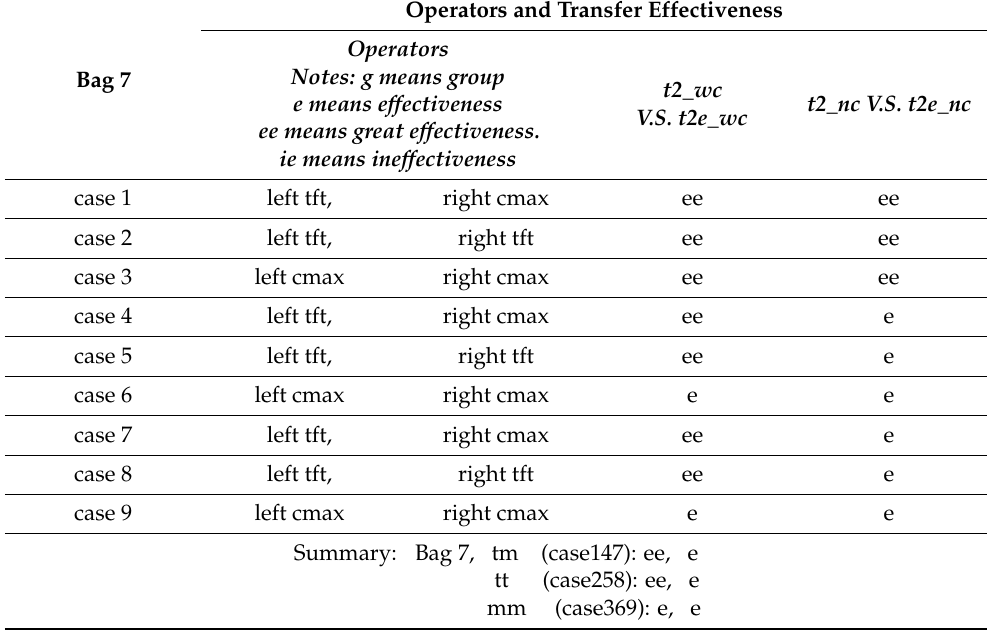
Table 3. Comparisons in Bag 7 for ETO_PFSP framework.